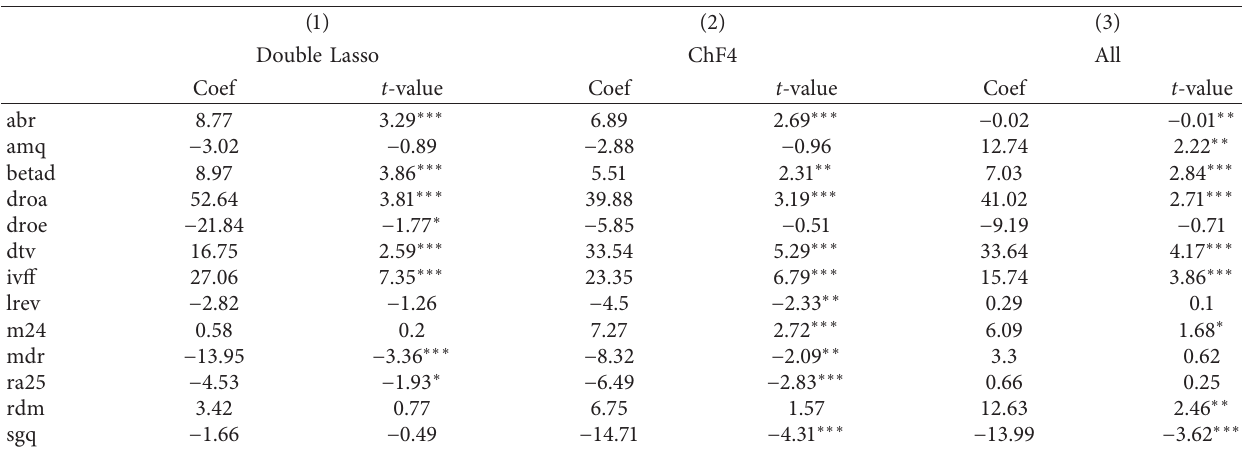
Table 8: Testing SDF loadings of g t . This table reports SDF loading estimates of 18 tested factors with significant risk premia in the A-share market. We use 650 5 × 5 bivariate sorted portfolios as test assets. Benchmark factors include all factors appearing in Table 3 as well as the liquidity factor AMI and Quality-Minus-Junk (QMJ) factor. The sample period is from July 2000 to December 2019. The first column uses double-selection LASSO approach to determine controlling factors. The second column only uses factors of Liu–Stambaugh–Yuan 4-factor model [15] as controls. The third column uses all 18 benchmark factors as